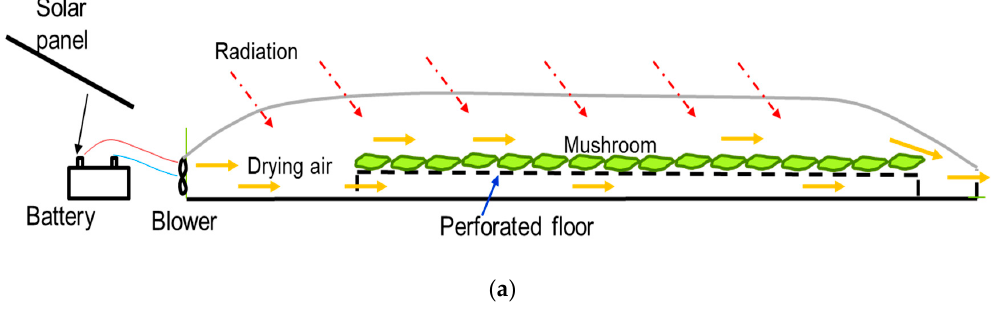
Figure 3. ( a ). Schematic diagram of the modified SBD for mushroom drying; ( b ) . Perforated floor (bubble dryer bed) and oyster mushroom inside the SBD; ( c ). T he SBD during drying (day time); ( d ). The SBD during non-working time (night).